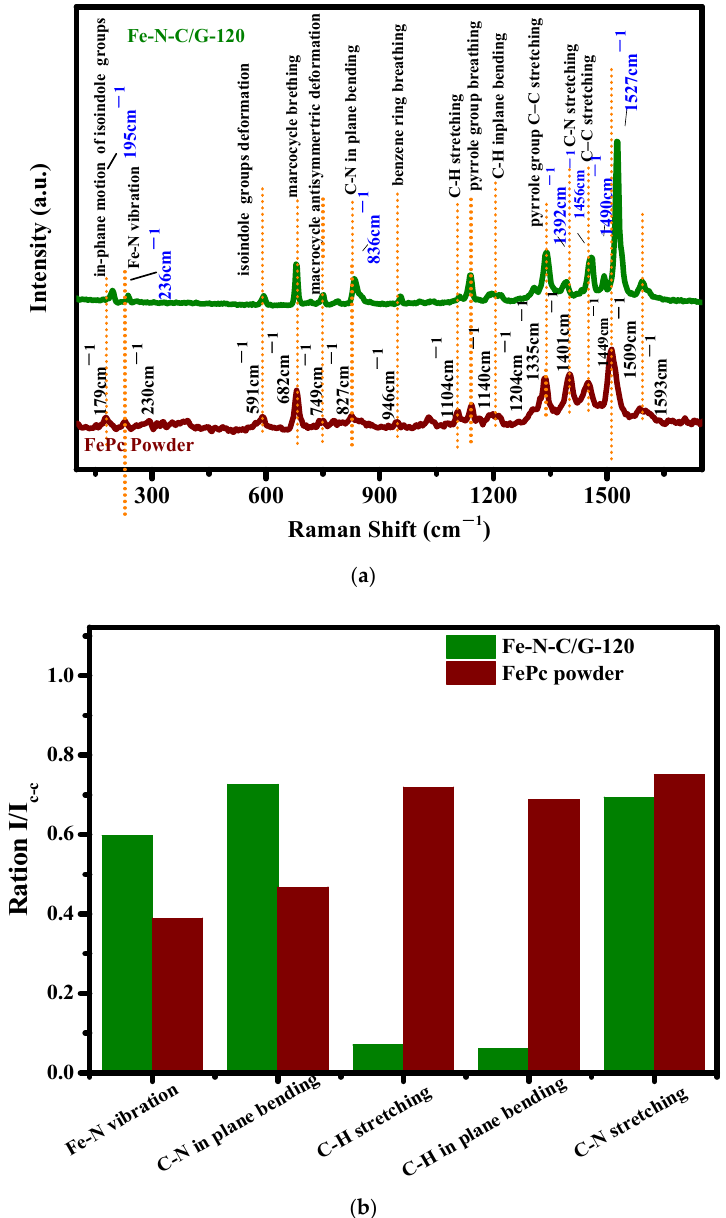
Figure 5. ( a ) Raman spectra of Fe–N–C-f catalyst and FePc powders; ( b ) peak intensity ratio I/I C-C calculated from the data in ( a ).